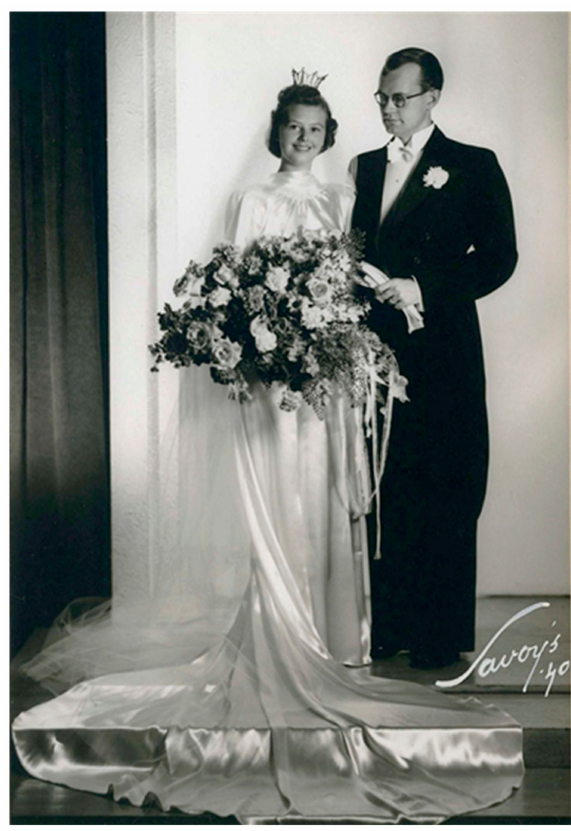
Figure 2. Gunnar Jungner and his wife Greta (born